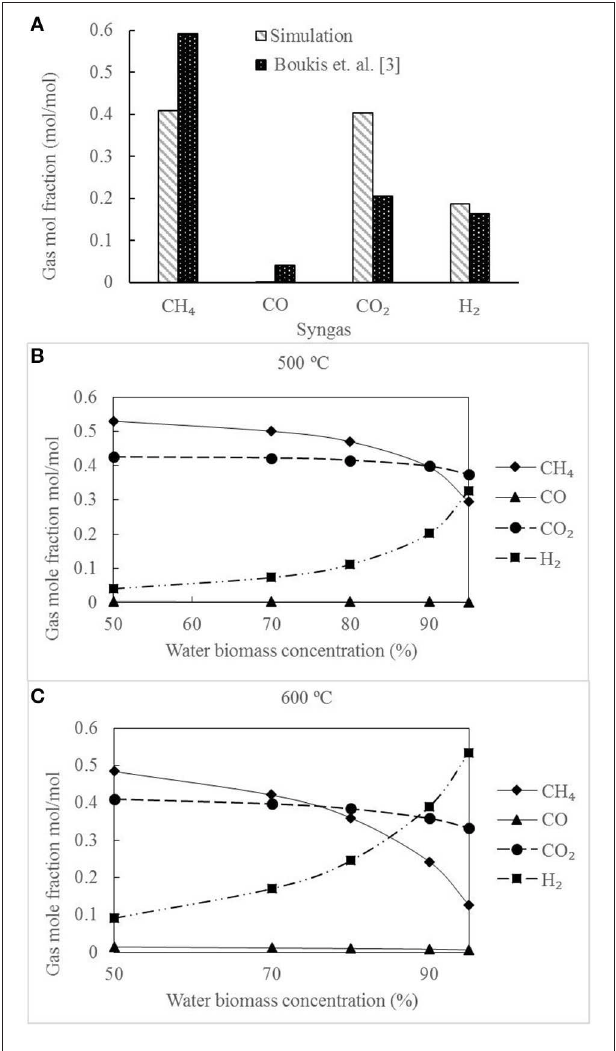
FIGURE 4 | (A) Product gas composition compared with reference gas product concentration at reactor temperature 450 ◦ C, pressure is 25 MPa, 6.7 wt.% moisture content at thermodynamic equilibrium (TE) and at non-equilibrium. (B) Product gas composition vs. biomass moisture and SCWG temperature at 500 ◦ C and (C) at 600 ◦